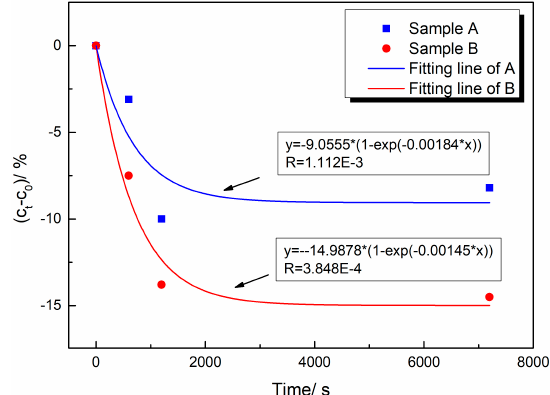
Figure 10. Details of crystals morphology after reaction lasted for 120 min.